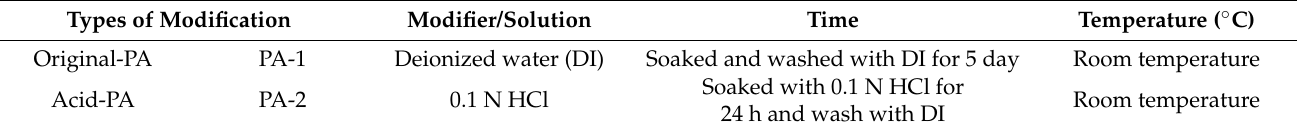
Table 1. PA preparation and acid modification